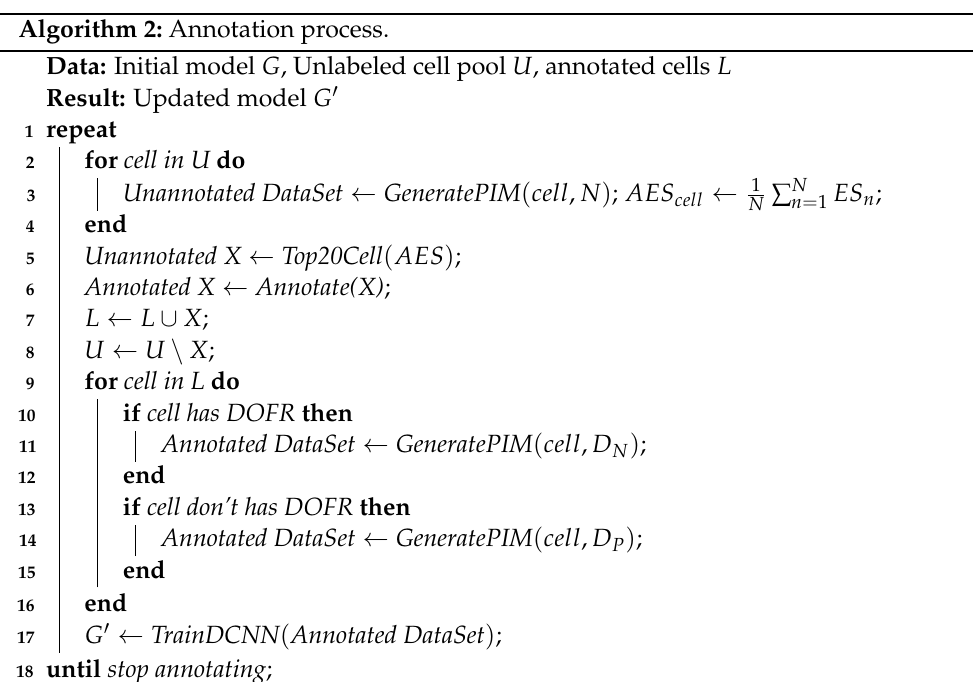
Algorithm 2: Annotation